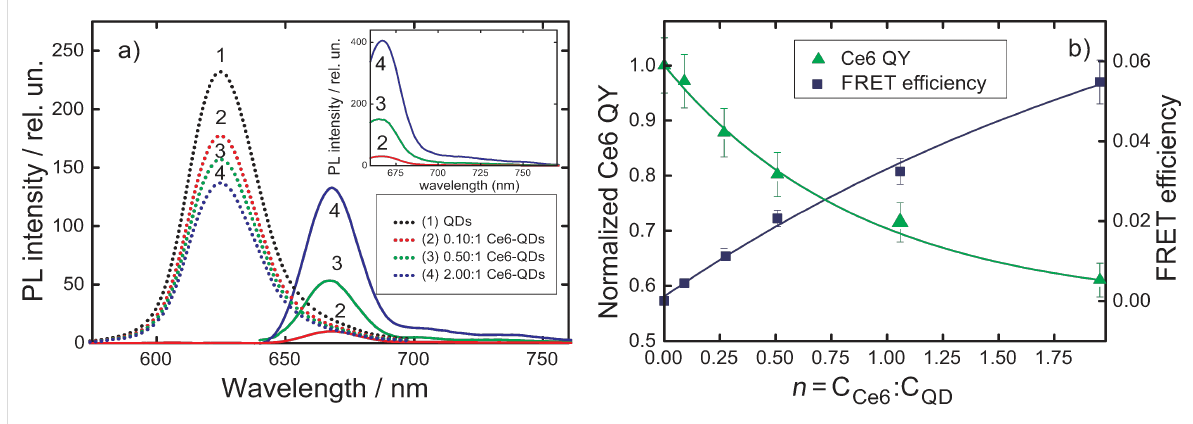
Figure 4: Optical properties of QD–Ce6 complexes formed by electrostatic interactions in aqueous solution as a function of n . (a) Evolution of PL spectra of 5 nm QDs (dotted line) and sensibilized luminescence of Ce6 (solid line) extracted from PL spectra of the QD–Ce6 complexes. The PL excitation wavelength is 475 nm. The intensity of the Ce6 emission is multiplied by 2. The inset shows PL spectra of the QD–Ce6 complexes with excitation at 640 nm. (b) FRET efficiency, estimated using Equation 5, and Ce6 QY as a function of n